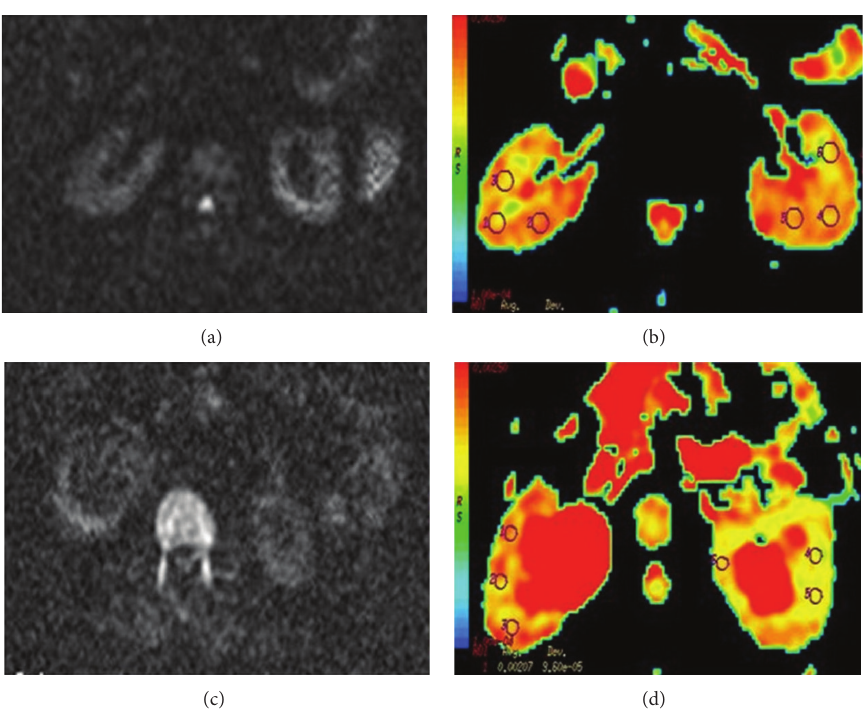
Figure 2: Normal kidneys ((a), (b)) and hydronephrotic kidneys ((c), (d)). Axial apparent diffusion coefficient (ADC) map calculated from echoplanar diffusion-weighted images of healthy and hydronephrotic kidneys with high b values at the central portion of normal, healthy kidneys ((a), (b)) and hydronephrotic kidneys ((c), (d)). A large circular region of interest (ROIs) was placed at the corticomedullary junction for the measurement of ADC values for normal and obstructed